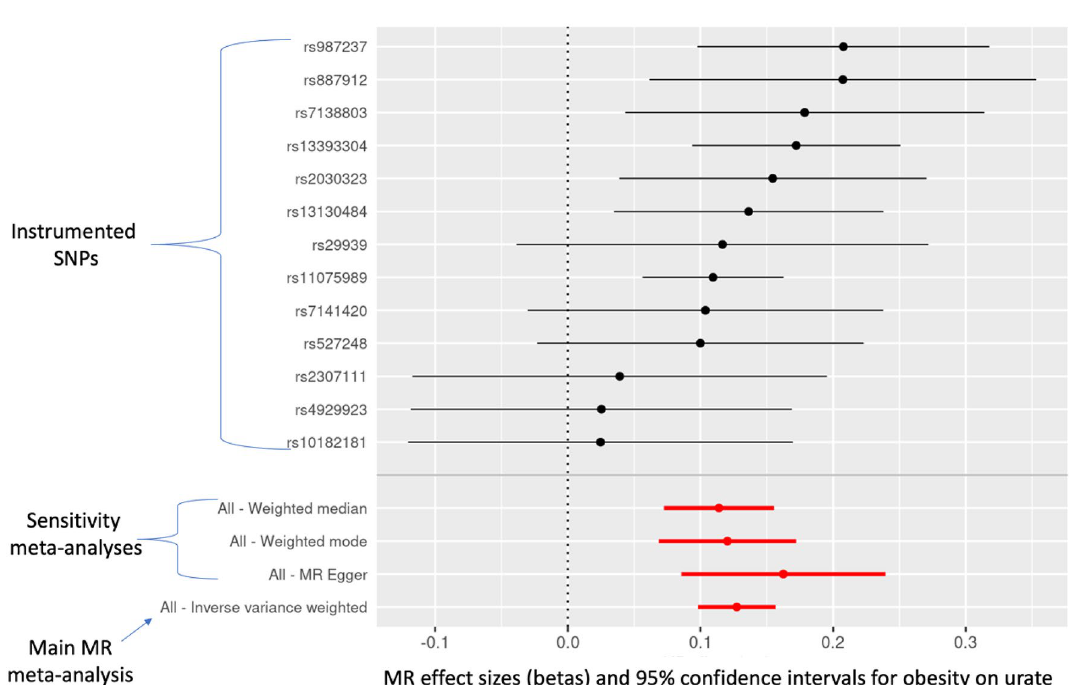
Figure 3. Individual-SNP and meta-analytic MR effect estimates and 95% confidence intervals for the effect of obesity on urate. Weighted median, weighted mode, and MR-Egger are sensitivity meta-analyses. The inverse- variance weighted (IVW) result is the main MR